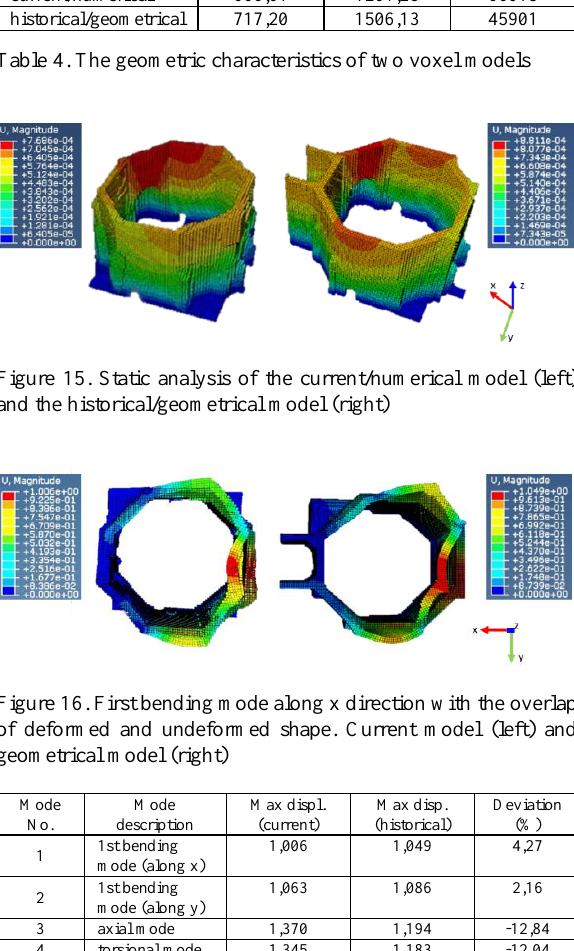
Figure 14. Cross sections